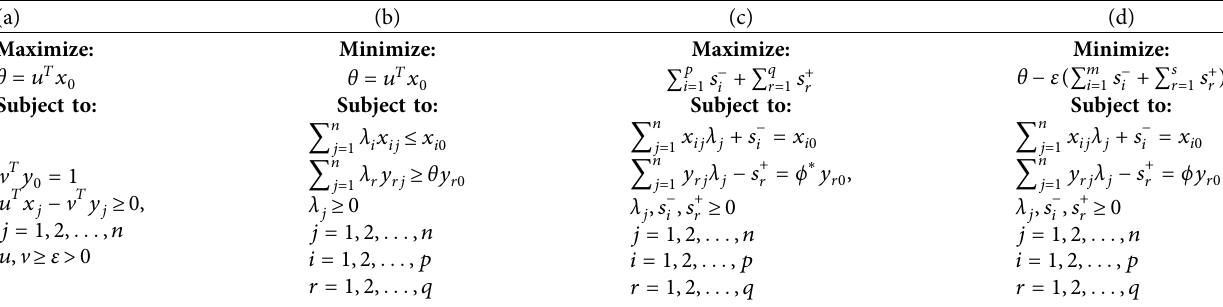
Table 2: Output-oriented CCR model.